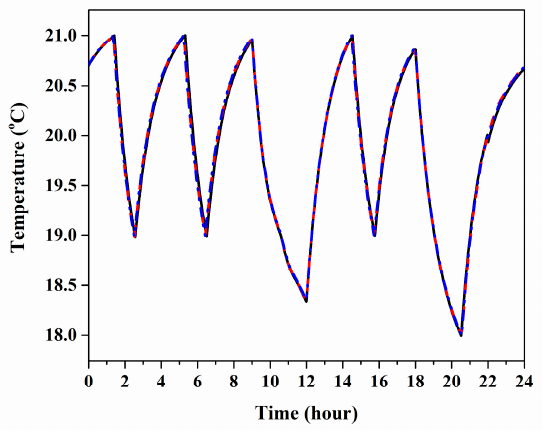
Figure 7. Comparison of indoor temperature (—: scenario 2 A, - -: scenario 2 B, and —- -: scenario 2 C).